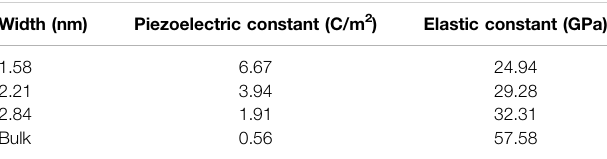
TABLE 1 | Piezoelectric and elastic constant of MoS thickness of 0.7 nm. Width